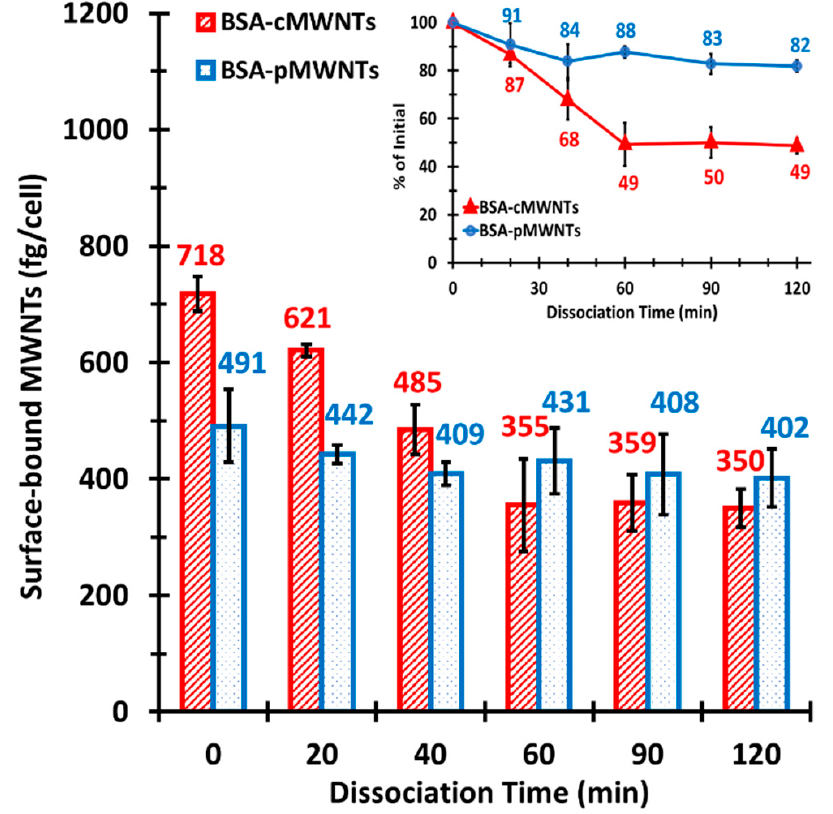
Figure 3. Dissociation of bound BSA-cMWNTs and BSA-pMWNTs from RAW 264.7 cells at 4 °C. A total of 100 µg/mL of BSA-cMWNTs or BSA-pMWNTs in serum- and sodium bicarbonate-free medium were incubated with RAW 264.7 cells at 4 °C for 1 h to achieve binding, then washed and incubated in serum- and sodium bicarbonate-free medium for the indicated times, as described in Methods. Surface-bound MWNTs were extracted and quantified by the SDS-PAGE method. The numbers above the bars are the mean femtograms of MWNTs/cell. Inset: The data are plotted as the percentage of the initial surface-bound MWNTs at t = 0 min. Data are the mean of ≥ 3 independent experiments ± SD.